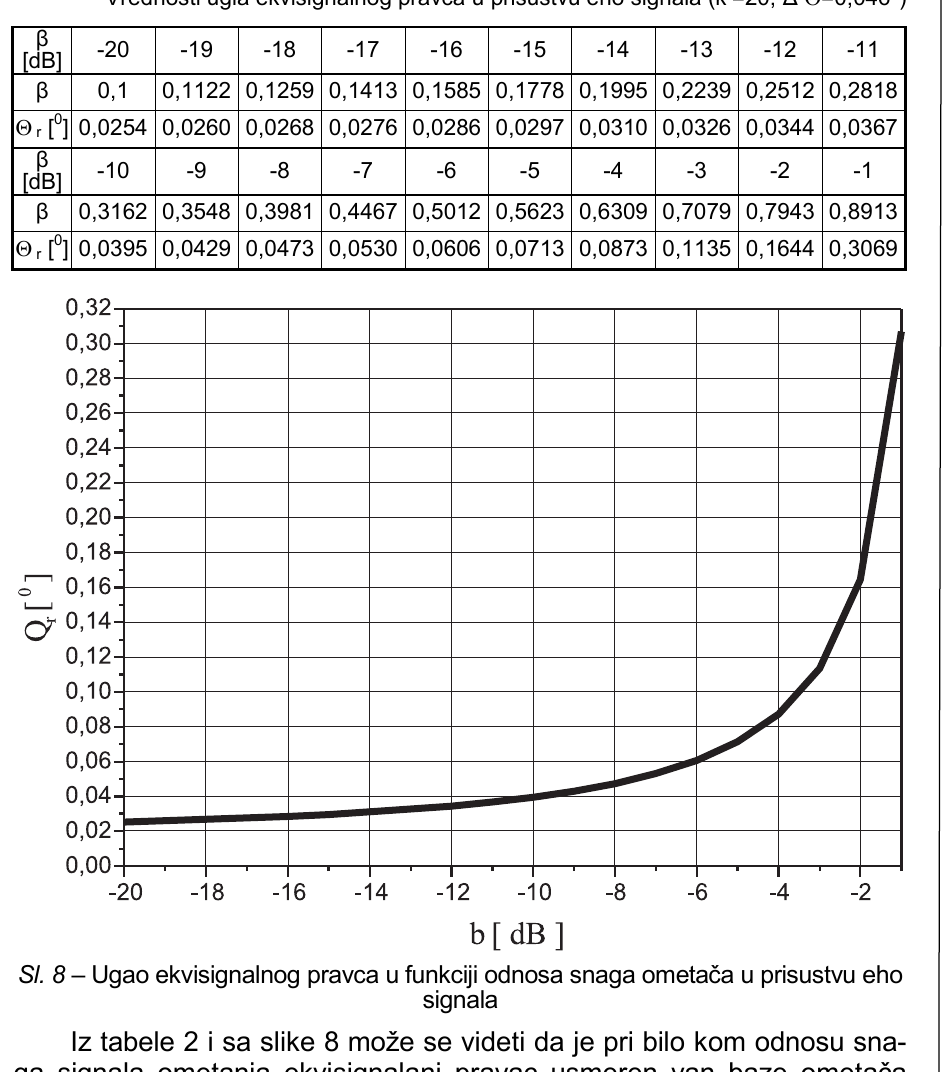
vu tabele 2 nacrtan je grafik na slici